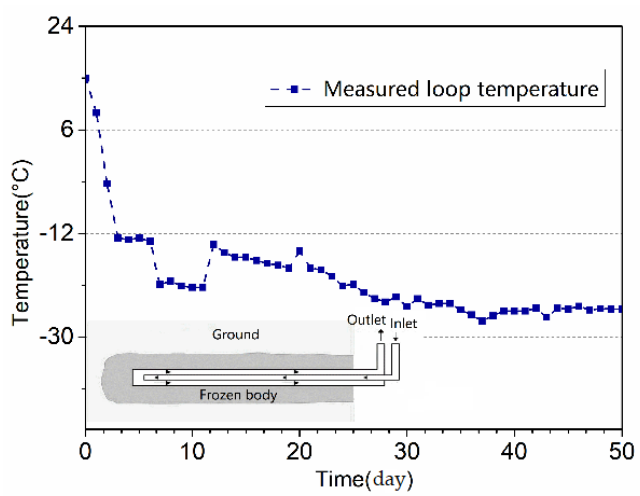
Figure 10. The measured temperature of the loop main-pipe during freezing period.